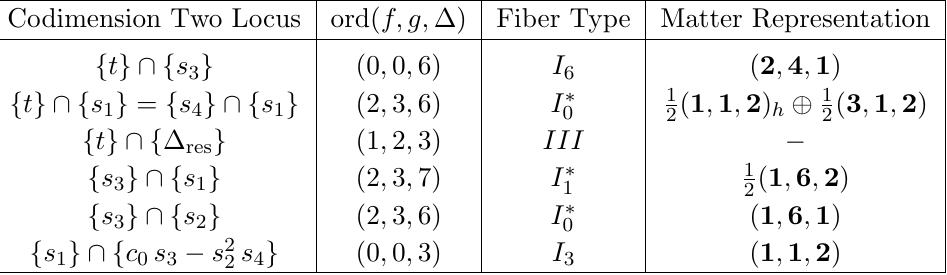
Table 1 . Singularity enhancements in codimension two. The corresponding matter representations, of the su (2) A (cid:8) su (4) (cid:8) su (2) B gauge algebra, of the 6D F-theory compacti(cid:12)cation are included. The 1 = 2 in the (cid:12)nal column indicates that at each codimension two point of that kind there exists a half-hypermultiplet instead of a full